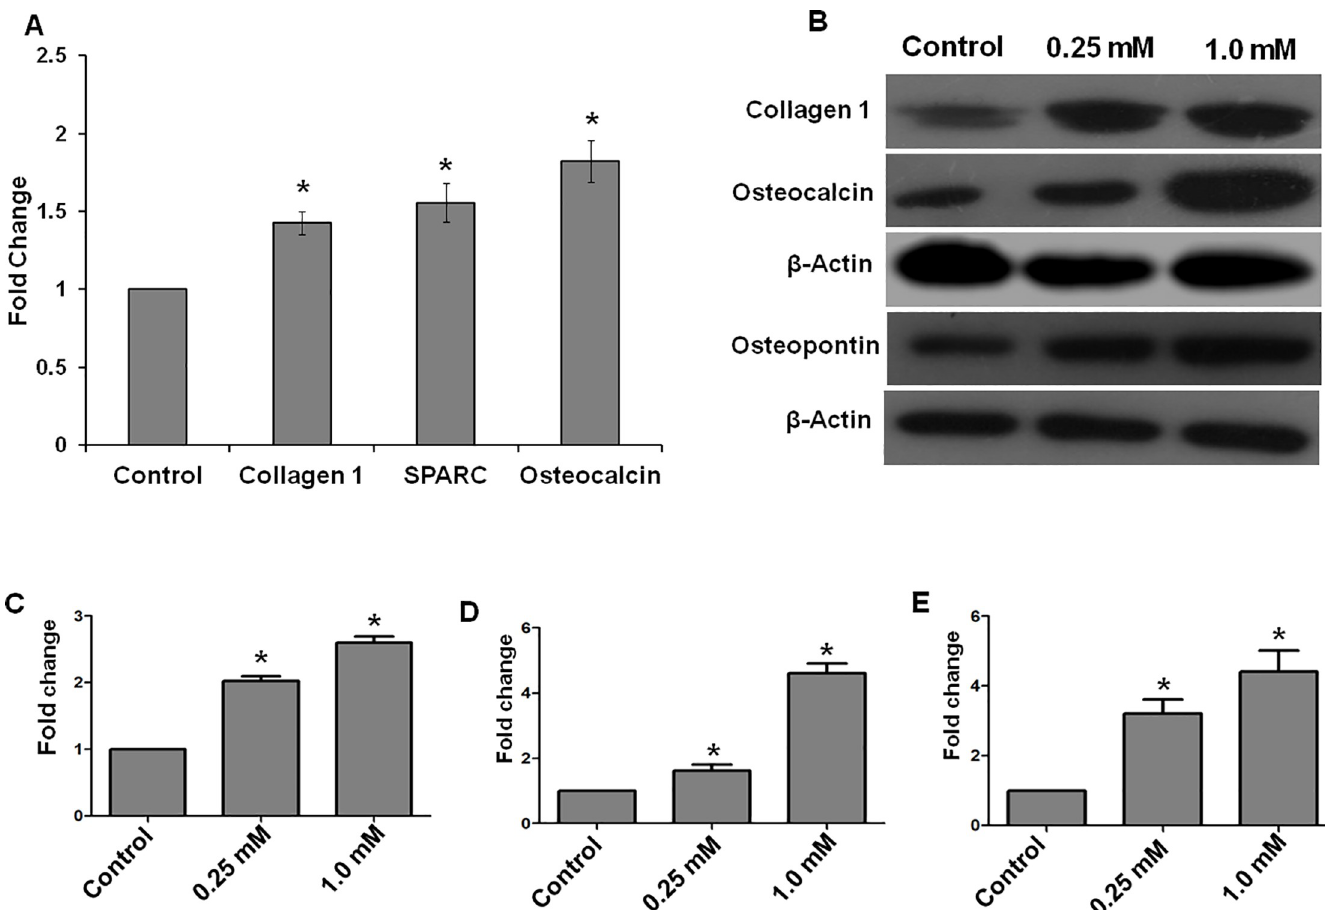
Fig 4. Changes in the expression pattern of osteopontin, osteocalcin, and collagen-1 in MG-63 cells treated with calcium glucoheptonate for seven days. (A) qRT-PCR results show fold-change in the expression of osteogenic genes in response to calcium glucoheptonate treatment. (B)- Western blot for collagen-1, osteocalcin and osteopontin respectively. (C-E) Densitometric analysis of collagen-1, osteocalcin and osteopontin. � denotes significant difference as compared to control (p < 0.05).